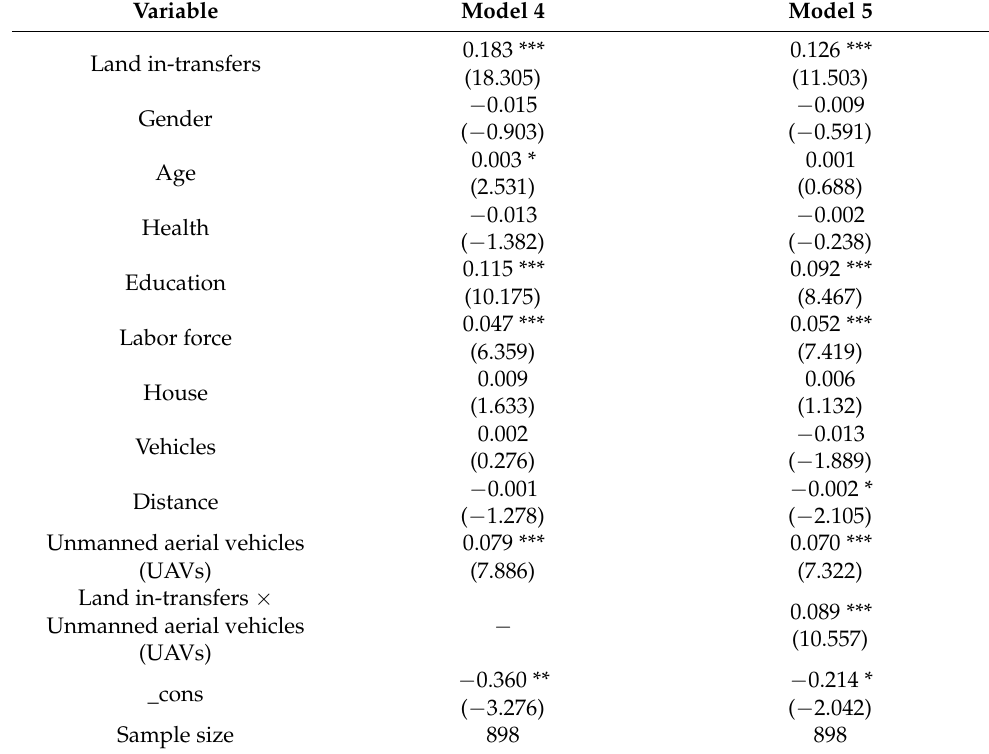
Table 6. Results of the moderating effect.